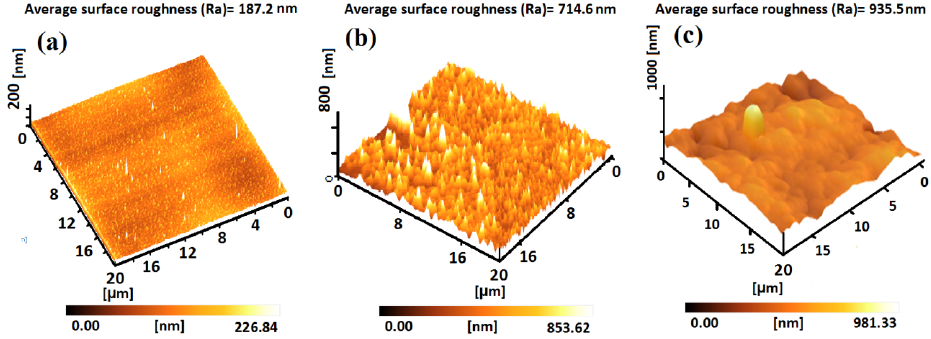
Figure 5. 3D ‐ atomic ‐ force microscopy (AFM) image of ( a ) uncoated, ( b ) MgO ‐ coated and ( c ) Si/MgO ‐ Figure 5. 3D-atomic-force microscopy (AFM) image of ( a ) uncoated, ( b ) MgO-coated and ( c ) coated samples after the ball milling ‐ cold pressing ‐ sintering process. Si/MgO-coated samples after the ball milling-cold pressing-sintering process.